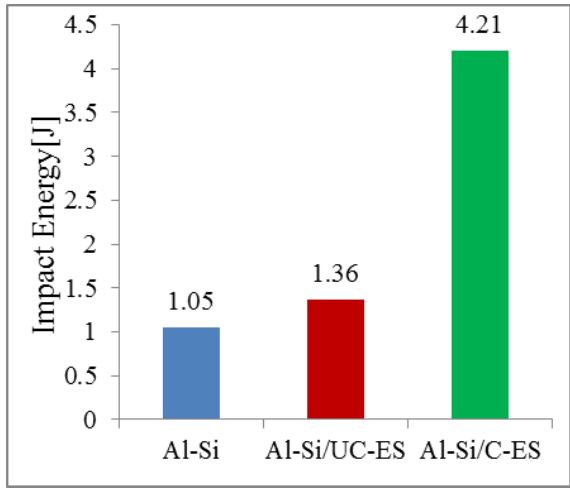
Fig. 14. Comparison of impact energy of control sample and the two